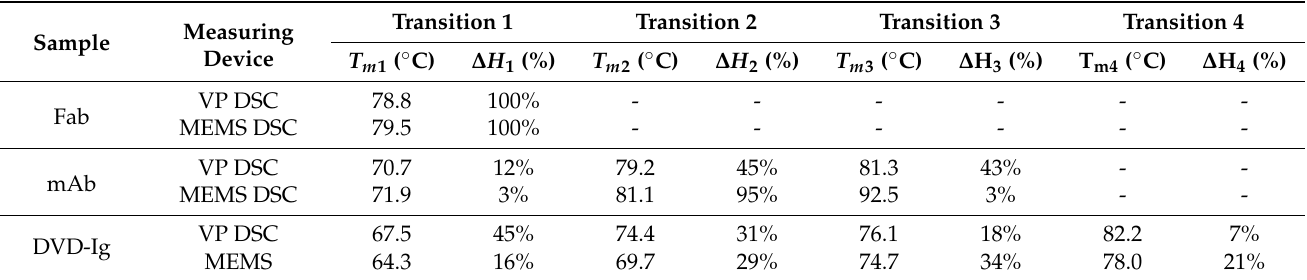
Table 1. Comparison of the DSC curves for denaturation of the three proteins measured by the VP DSC and MEMS